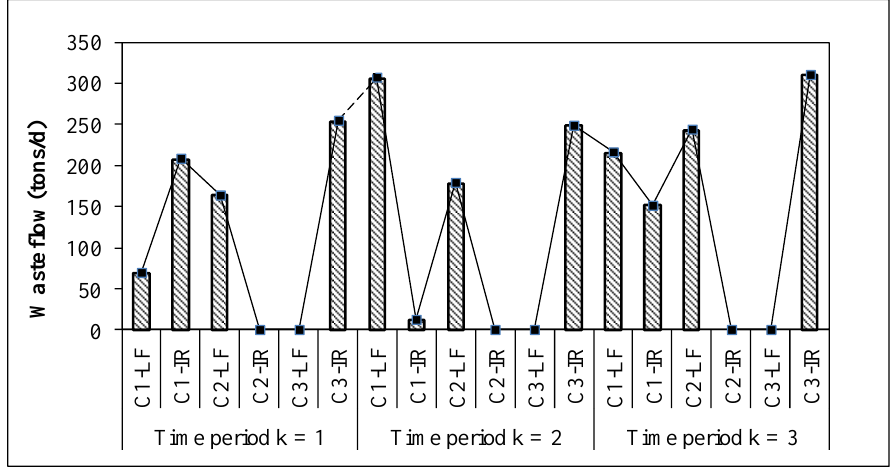
Figure 4. Waste flow from cities to facilities under ω 1 = ω 2 = 0.4, β = 0.9 (where C1, C2, and C3 represent cities; and LF and IR represent the landfill and the incinerator, respectively. There are 18 conditions including C1-LF on k = 1, C1-IR on k = 2, and so on).